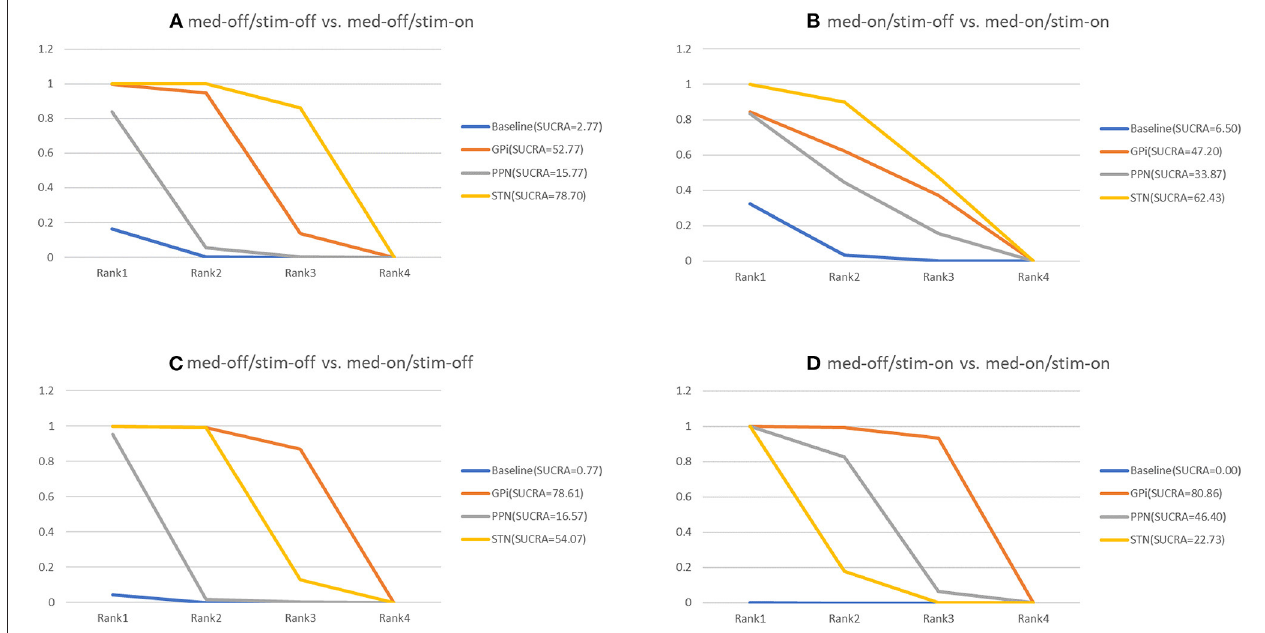
FIGURE 8 | Cumulative rank of three surgical intervention of UPDRS-III (Total); (A) med-off/stim-off vs. med-off/stim-on, (B) med-on/stim-on vs. med-on/stim-on, (C) med-off/stim-off vs. med-on/stim-off, (D) med-off/stim-on vs.